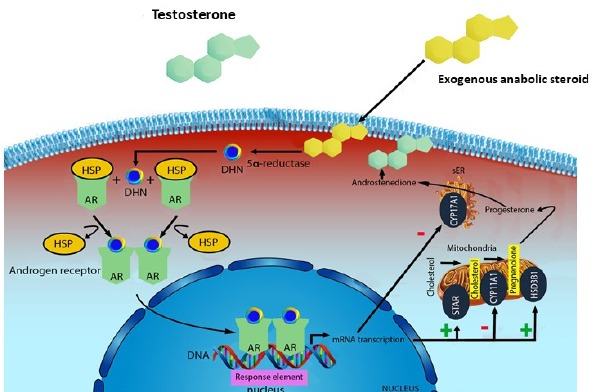
Figure 1. Mechanism of action of exogenous anabolic steroids: an anabolic steroid is transported into the target tissue cell cytoplasm where it can either bind the androgen receptor, or be reduced by the cytoplasmic enzyme 5-alpha reductase. The N-receptor complex undergoes a structural change that allows its translocation into the cell nucleus, where it directly binds to specific nucleotide sequences of the chromosomal DNA. The produced DNA interferes with the physiological biosynthesis of testosterone.